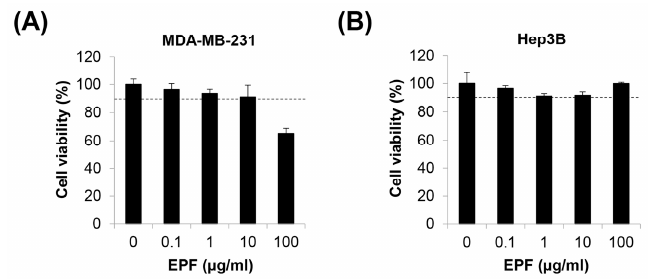
Figure 4. Effects of EPF on the viability of cancer cells. MDA-MB-231 human breast cancer cells ( A ) and Hep3B human hepatocellular carcinoma cells ( B ) were treated with EPF at diverse concentrations (0.1–100 µ g/mL) for 24 h. Cell viability was measured by MTT assay. The dotted line indicates 90% cell viability. EPF, ethanol extract of Perilla frutescens